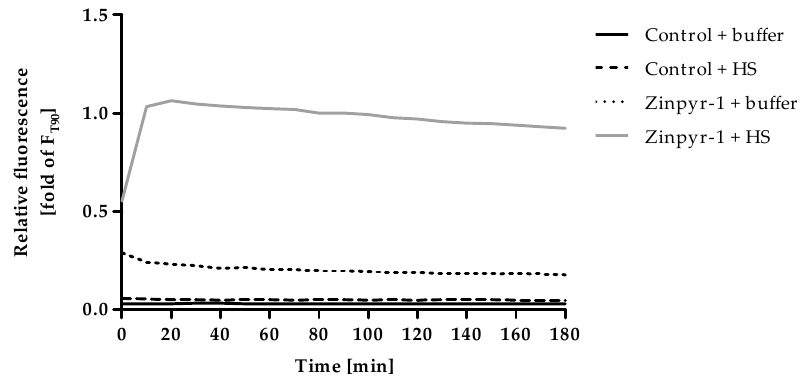
Figure 2. Kinetics of F. Controls (assay-buffer alone) or Zinpyr-1 (final concentration 0.05 µM in assay-buffer) were equilibrated to 37°C and the experiment started by adding 2% (v/v) human serum (HS) or an equal volume of assay-buffer. Fluorescence was measured in 10 min intervals for a total duration of 180 min. Data are shown relative to the fluorescence of Zinpyr-1 + HS after 90 min (= value for F used in the final assay procedure) and represent means of n = 3 independent experiments.